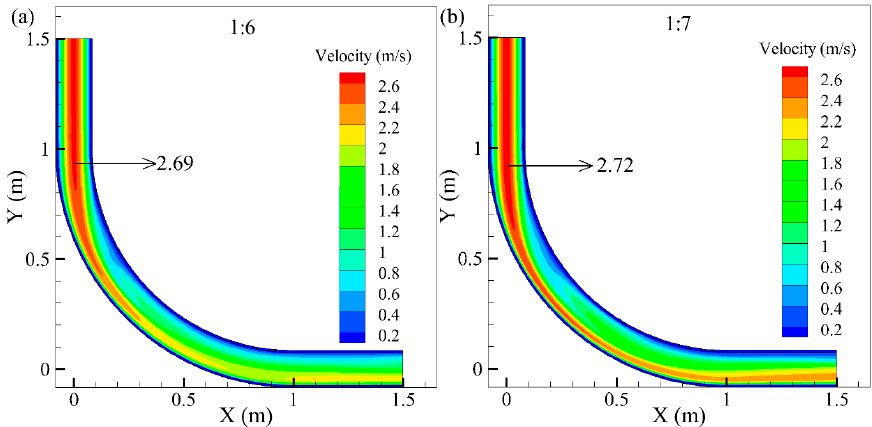
Figure 8. Velocity contours at the elbow for different leaching residue:classified tailings mass ratios: ( a ) 1:6 and ( b ) 1:7.